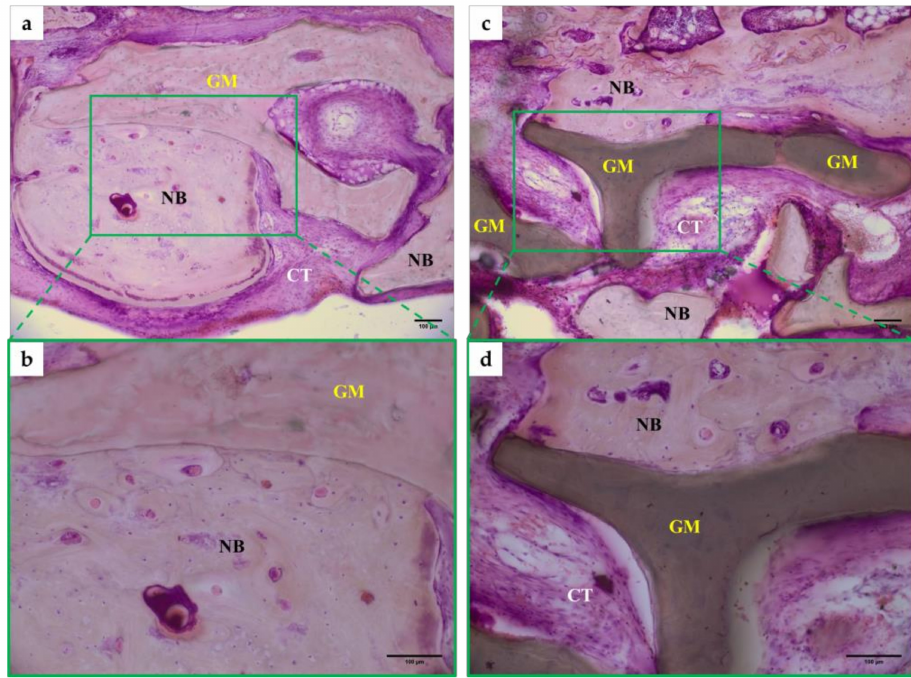
Figure 5. Image of Histomorphormetric analysis in a rat calvarial at 8 weeks. ( a , b ) Bio-Oss ® at 8weeks, ( c , d ) Ti-oss ® at 8 weeks. All groups was H&E staining and observed × 100 and × 200 with an optical microscope. NG: New Bone, GM; Graft Material, CT; Connective